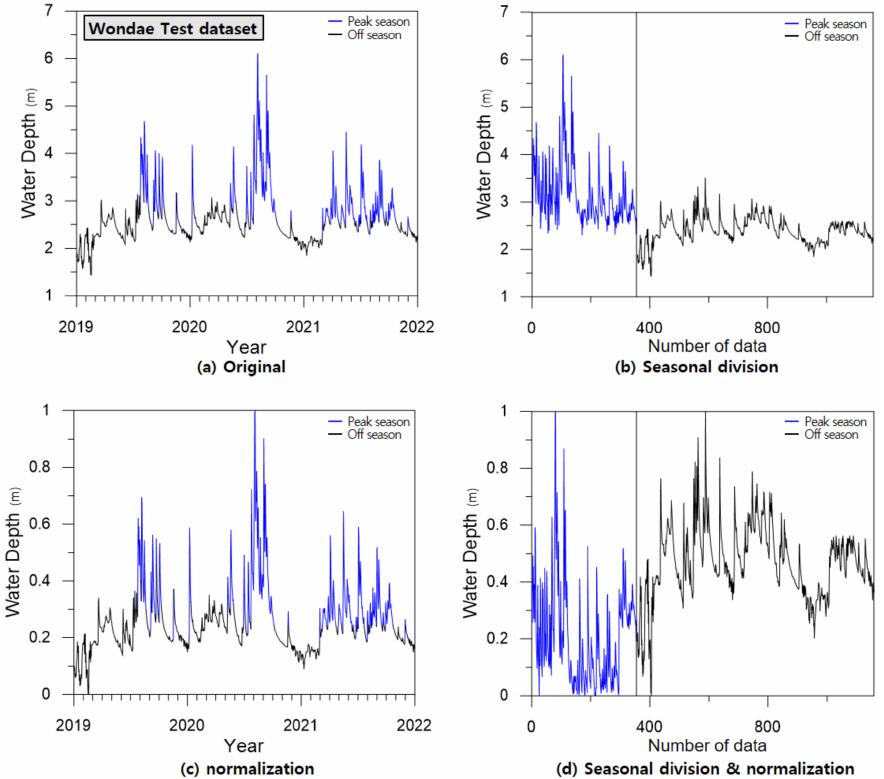
Figure 7. Data separation according to the type of preprocessing. Four types of preprocessing methods were applied to the MLP and RMLP models.